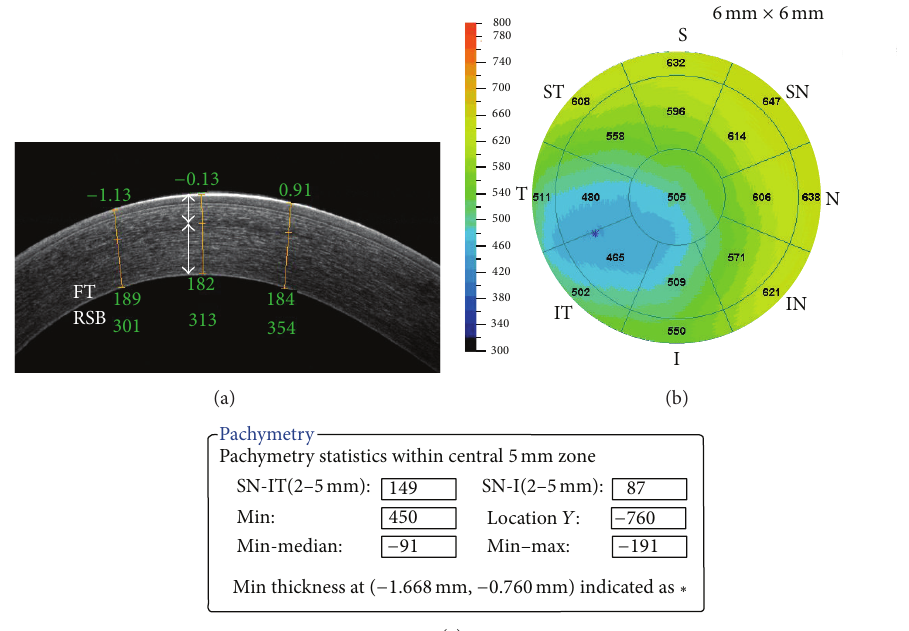
Figure 6: AS-OCT image of post-LASIK keratectasia. Horizontal OCT section demonstrating flap thickness (FT) and residual stromal bed thickness (RSB) (a), pachymetry map (b), and asymmetry parameters (c).